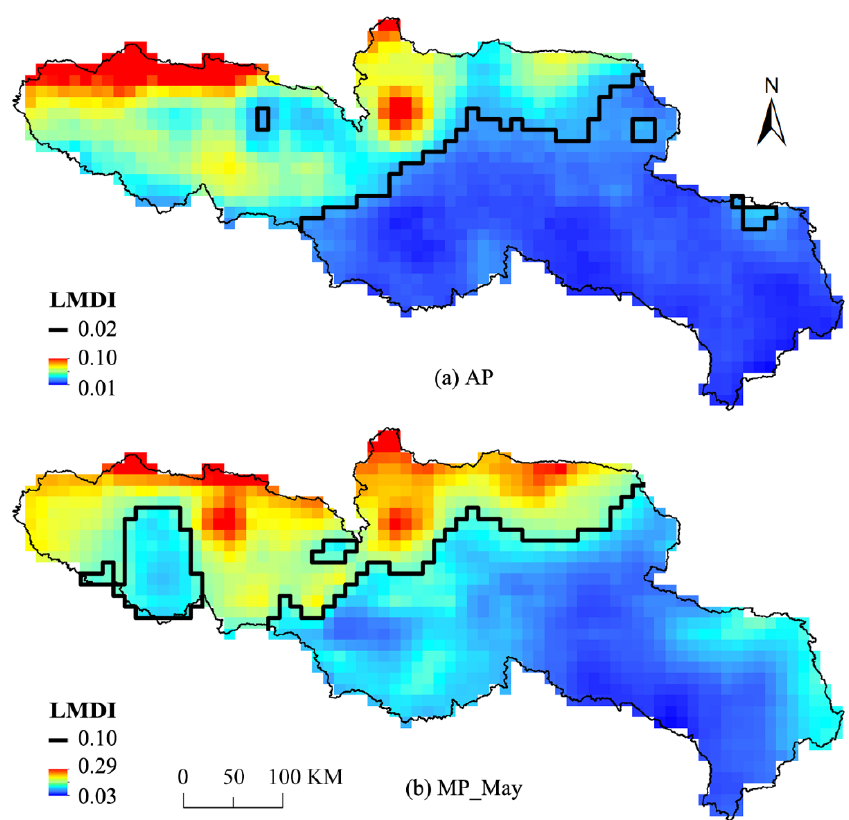
Figure 11. Spatial distribution of LMDI for AP ( a ) and MP in May ( b ) during 1979–2015, with a Figure11. SpatialdistributionofLMDIforAP( a )andMPinMay( b dividing line.